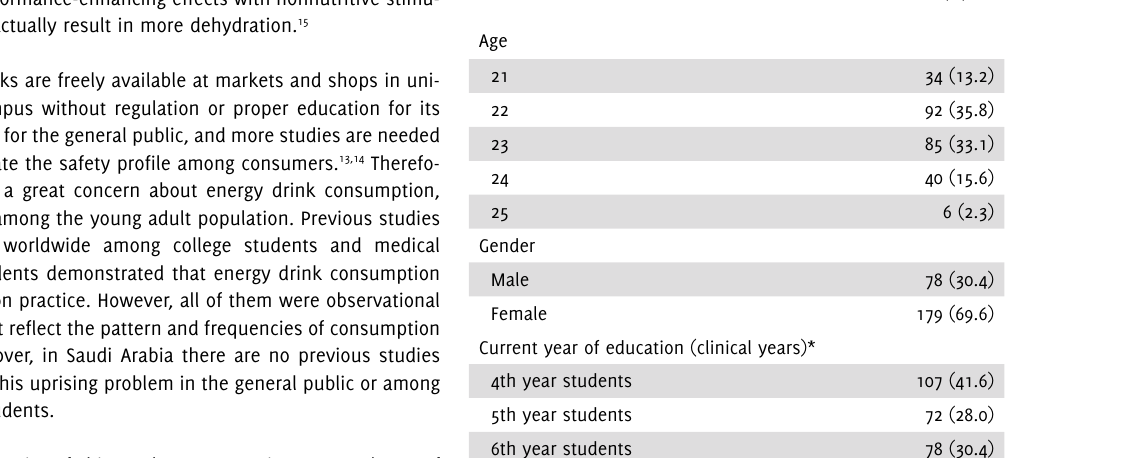
Legend: Current year of education in a 6-year program.